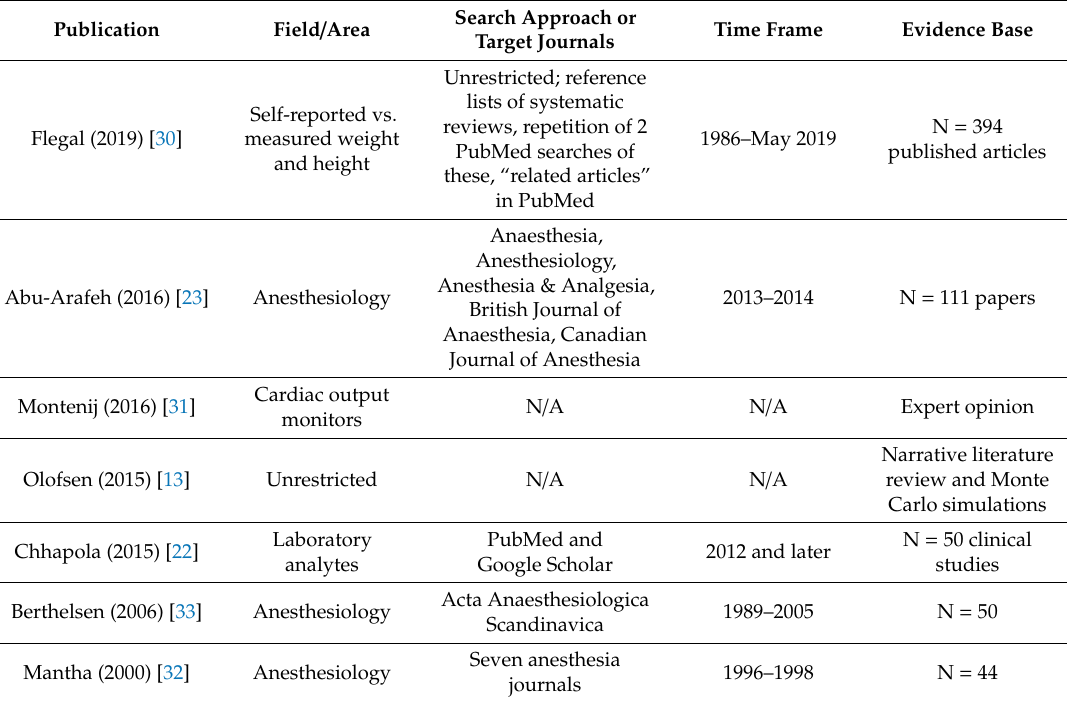
Table 1. Characteristics of studies